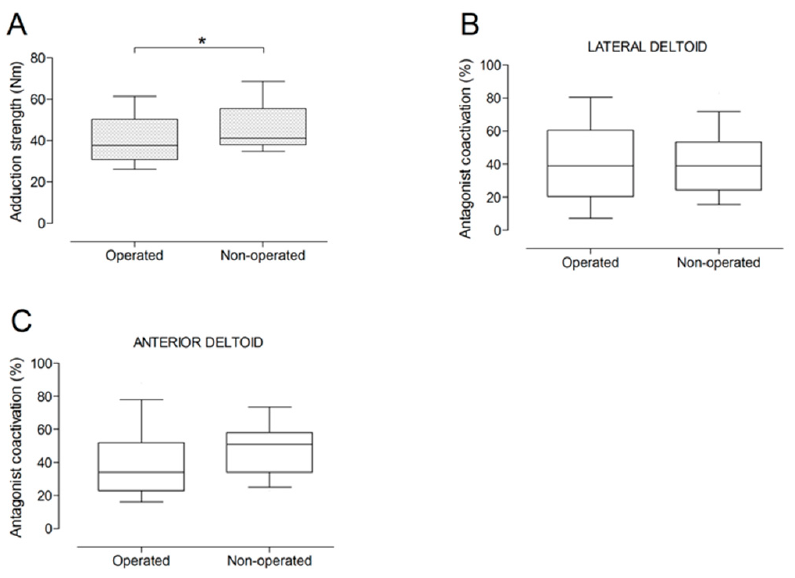
Figure 5. Box and whisker plots of shoulder adduction strength ( A ) and antagonist coactivation of lateral deltoid ( B ) and anterior deltoid ( C ) muscles by side. The horizontal line in the box represents the median, the height of the box represents the interquartile range, and the distance between the opposite ends of the whisker represents the 10 th –90 th percentile. *Operated < non-operated ( p < 0.05).